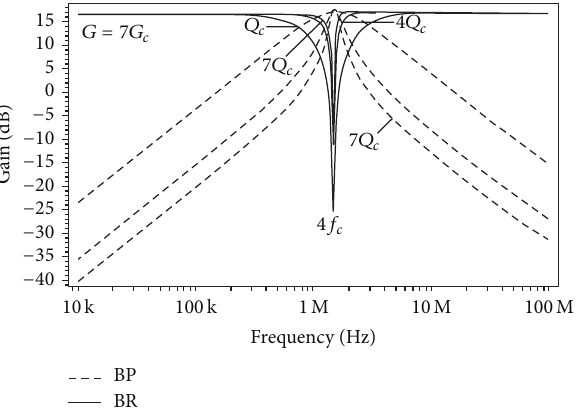
Figure 9: Quality factor programming of BP and BR.